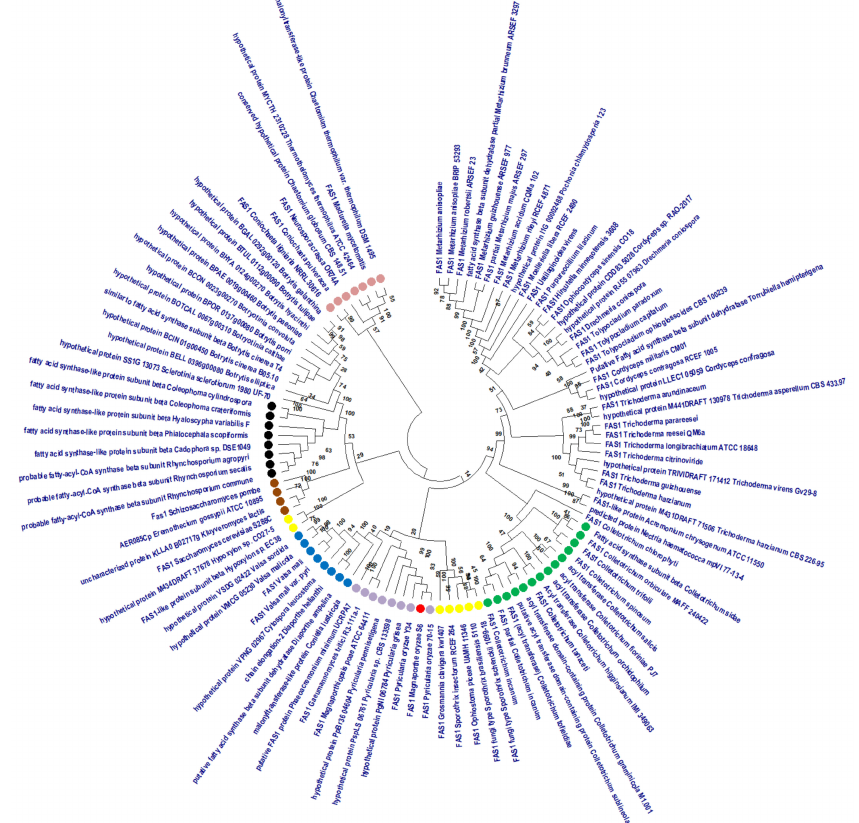
Figure 3. Molecular phylogenetic analysis by Maximum Likelihood method with bootstrap value on the branches. The evolutionary history was inferred by using the Maximum Likelihood method and Jones-Taylor-Thornton (JTT) matrix-based model [46]. The bootstrap consensus tree inferred from 1000 replicates is taken to represent the evolutionary history of the taxa analyzed [47]. Branches corresponding to partitions reproduced in less than 50% bootstrap replicates are collapsed. Initial tree(s) for the heuristic search were obtained automatically by applying Neighbor-Join and BioNJ algorithms to a matrix of pairwise distances estimated using a JTT model, and then selecting the topology with superior log likelihood value. This analysis involved 105 amino acid sequences. All positions with less than 95% site coverage were eliminated, i.e., fewer than 5% alignment gaps, missing data and ambiguous bases were allowed at any position (partial deletion option). There were a total of 2076 positions in the final dataset. Evolutionary analyses were conducted in Molecular Evolutionary Genetics Analysis Version 10 MEGA X